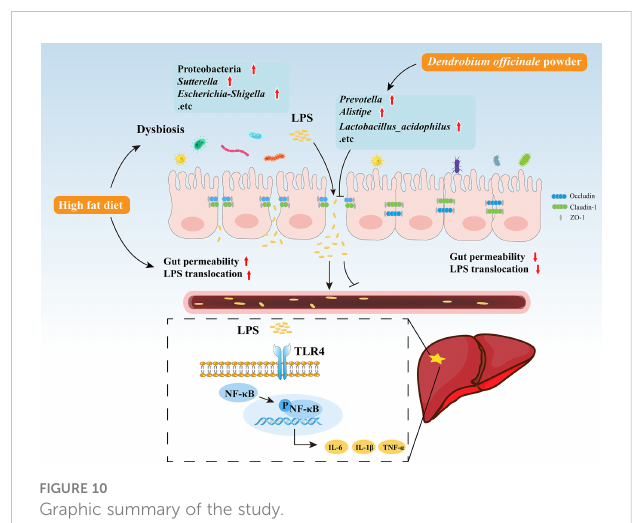
FIGURE 10 Graphic summary of the